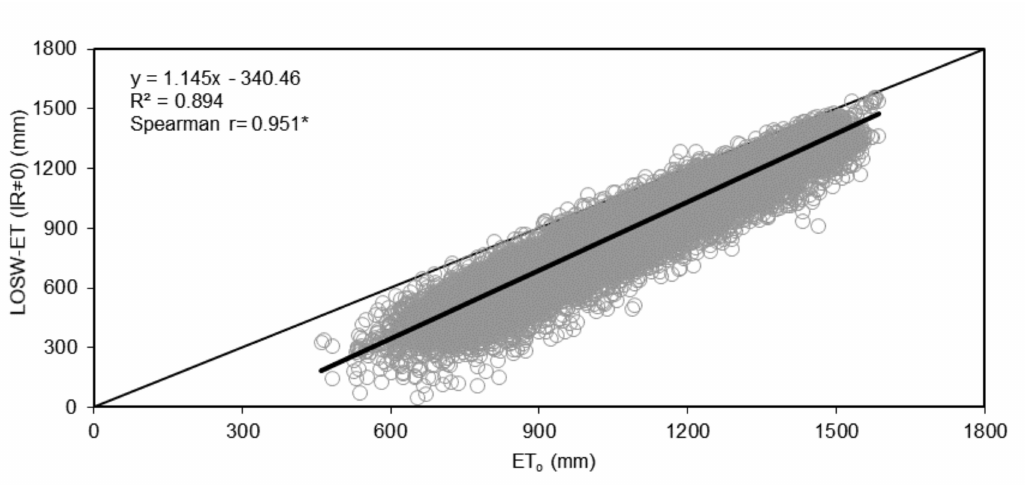
Figure 8. 1:1 plot between mean annual actual evapotranspiration of LOSW-ET ( IR (cid:54) = 0) versus ET o for the period 1950–2000 (15% of random data selection and exclusion of regions with K s =